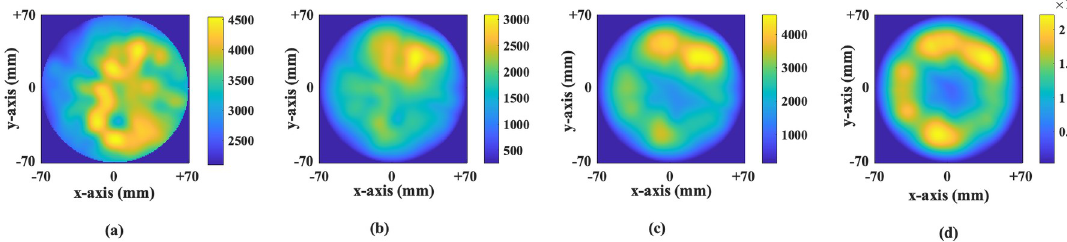
Fig 3. Microwave images of a single breast for different conductivity level generated via the MammoWave signal. (a) represent the image created for σ 1 conductivity level, (b) represent the image created for σ 2 conductivity, (c) represent the image created for σ 3 conductivity, and (d) represent the image created for σ 4 conductivity. Images given here are two-dimensional (2D) image in the azimuthal, i.e. coronal, plane. The x-axis and y-axis are given in meter and the colour bar represents the intensity in arbitrary